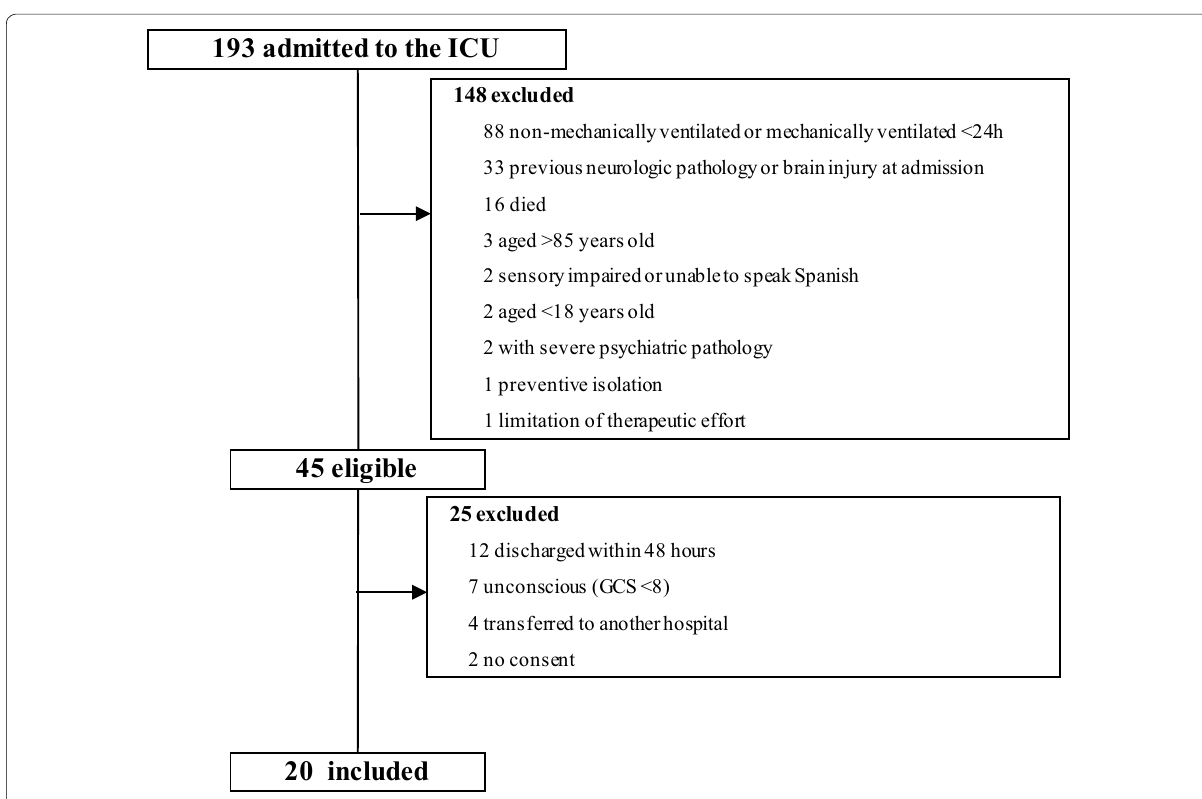
Fig. 2 Flow diagram of sample. During a period comprising ~9 months, 193 patients were admitted to the ICU; 148 met at least one exclusion criterion. Of the 45 eligible patients, 25 were finally excluded. Thus, 20 patients received the early neurocognitive